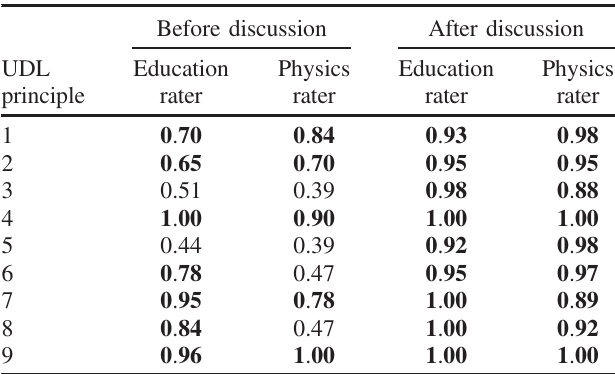
TABLE III. Inter-rater reliability results. Bold font indicates at least substantial agreement between the raters. Before discussion After